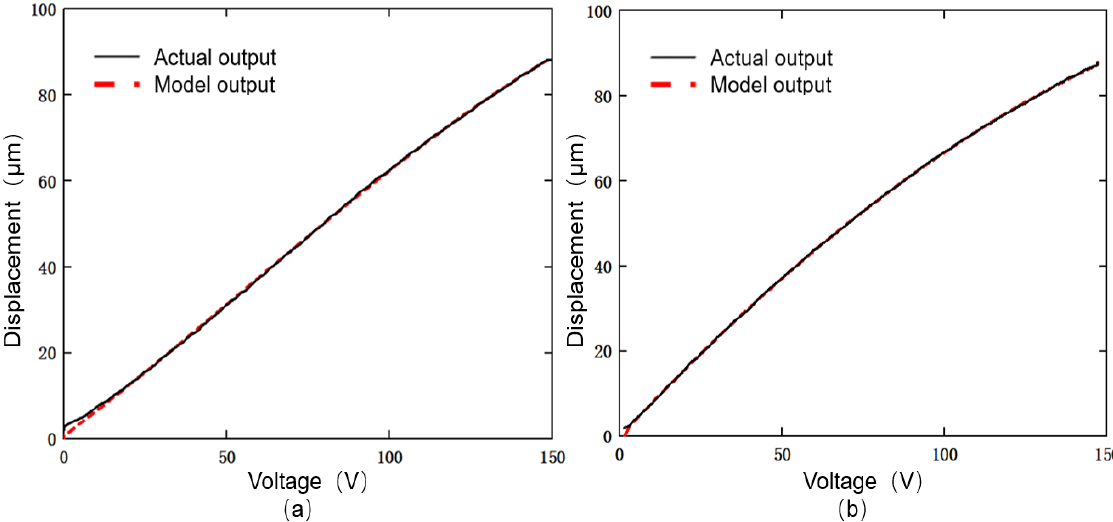
Figure 8. Fitting curve between model data and experimental data of improved artificial fish swarm algorithm: ( a ) ascending segment; ( b ) descending segment.